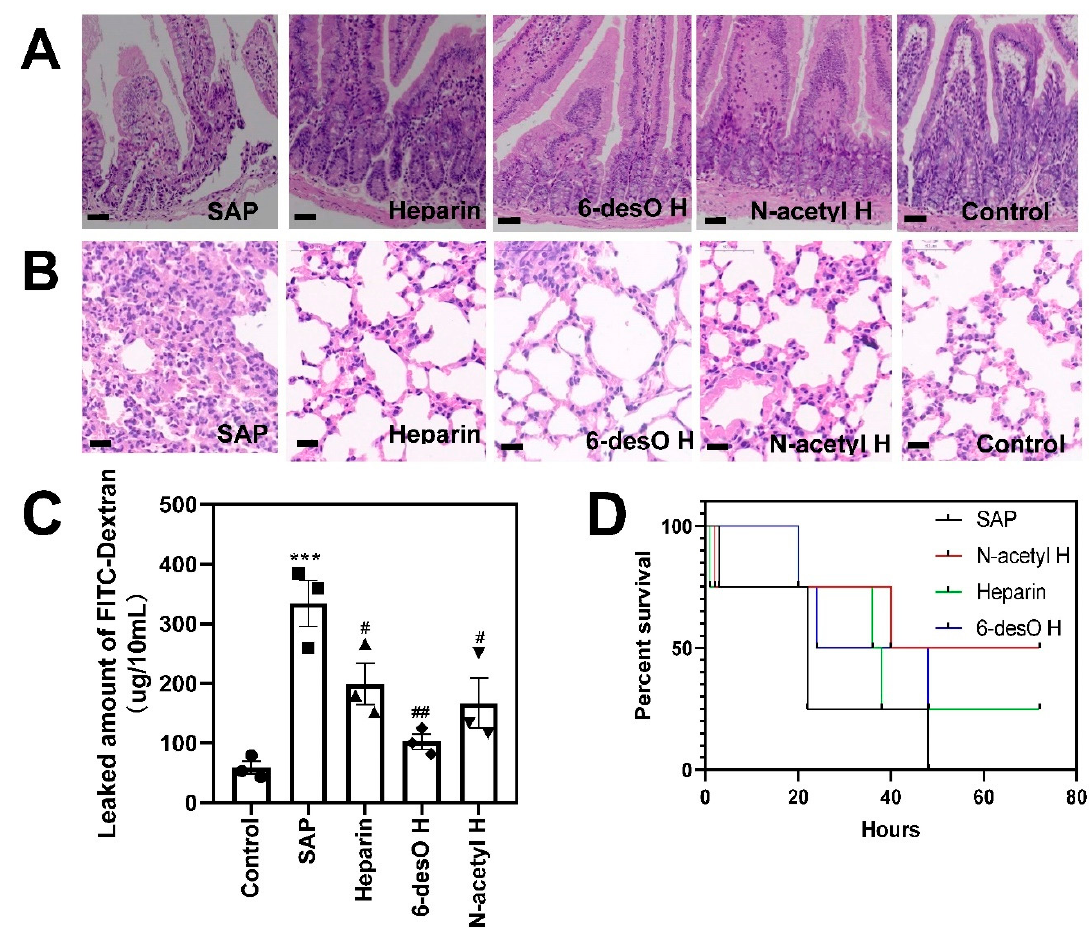
Figure 4. Heparin and its derivatives rescued the SAP mice from multiple organ failure during SAP development. ( A , B ) The representative H&E images of intestinal tissues ( A ) and lung ( B ). ( C ) The permeability evaluation of intestinal tissue (Scale Bars = 20 µm). ( D ) The survival rate calculation during 80 h after L-arginine challenges (# p < 0.05, ## p < 0.01, SAP vs other groups; *** p < 0.001, SAP vs. control groups).